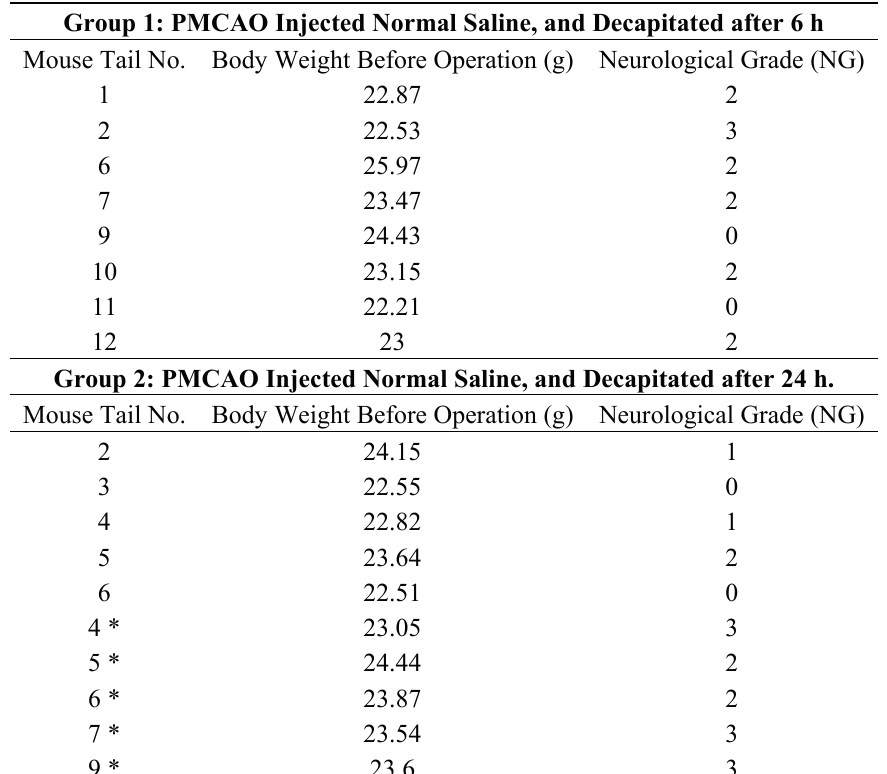
Table 2. The number of mice used for this experiment. A total of 23 mice were prepared, and 3 each were selected randomly based on neurological grade (NG). Mice with score 0 and 3 were not selected for sampling the